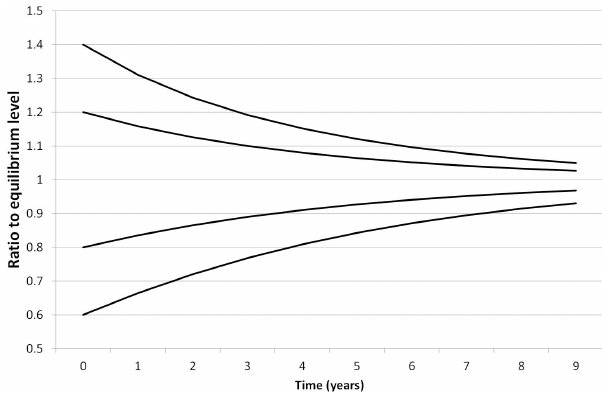
Figure 2. Examples of the response in levels for Lake Malawi from initial values equal to 0.6, 0.8, 1.2 and 1.4 times the long-term equi- librium